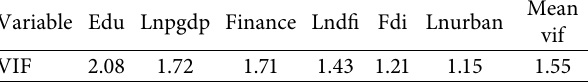
Table 2: Multicollinearity